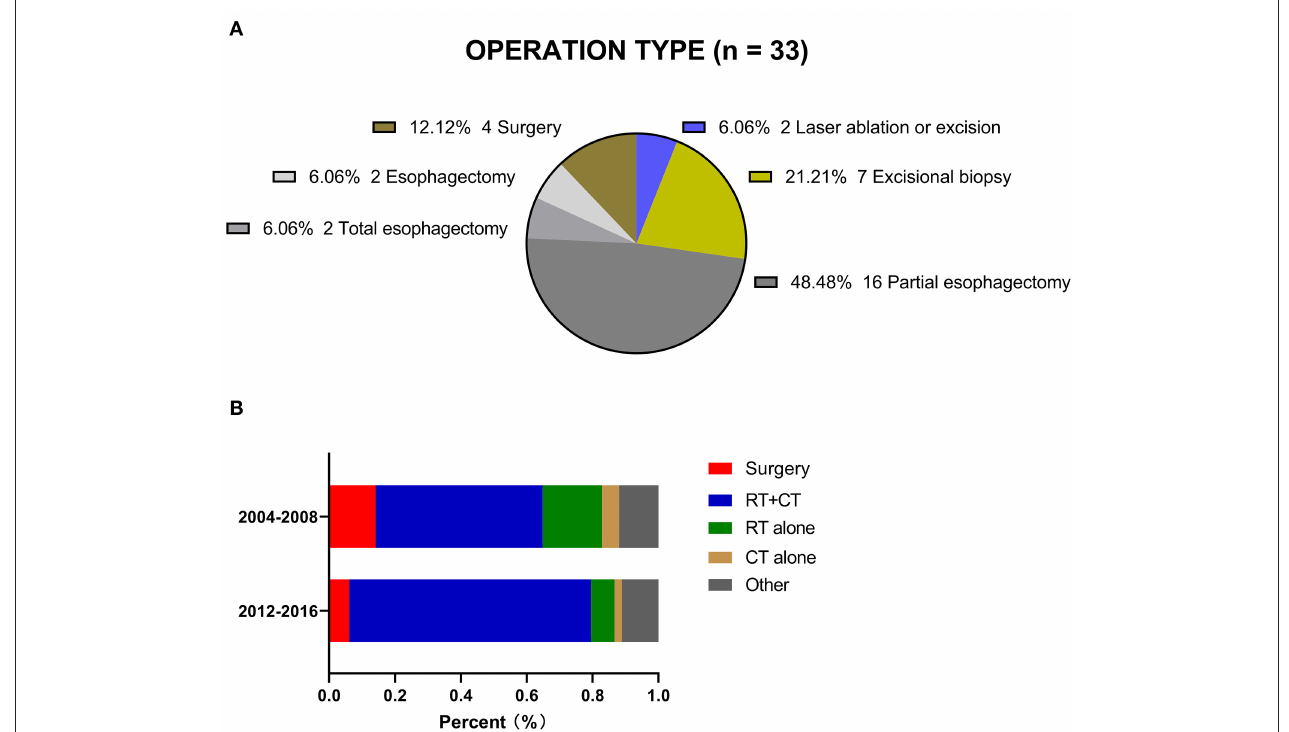
FIGURE 2 | (A) Operation type registered in the SEER. (B) Two treatment periods for CEC patients in the